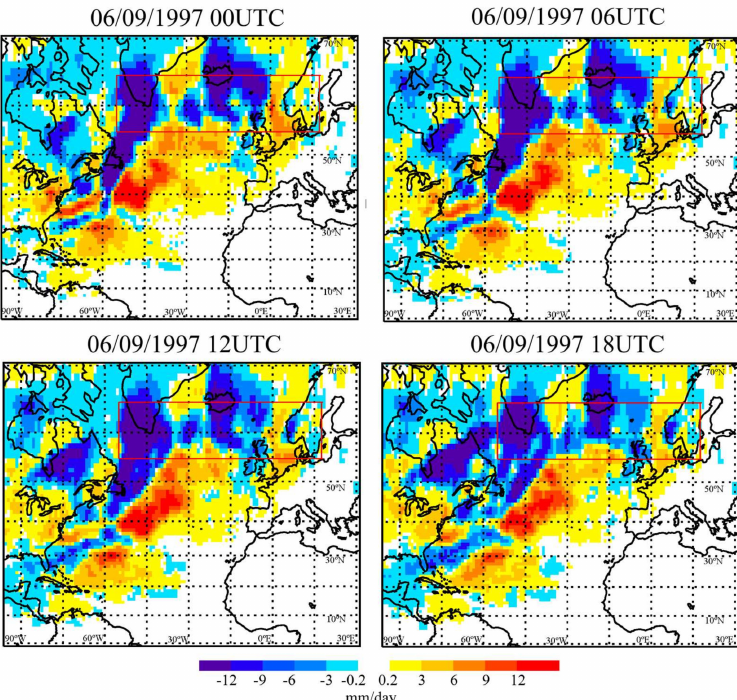
Figure 5. Total (E-P) values calculated for the 6 September 1997 (at every time step). The red box represents the ARs pathway box for the season. Scale in